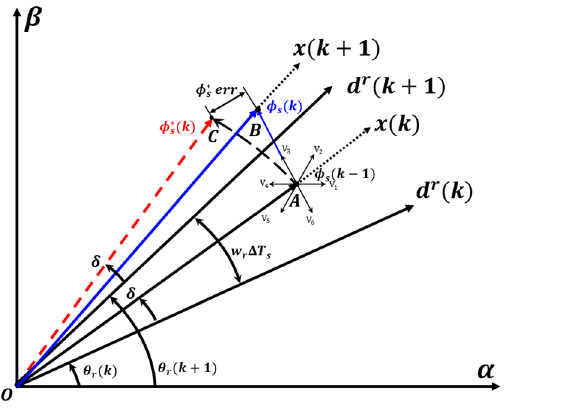
Figure 3. Block diagram of DTC-SVM control .